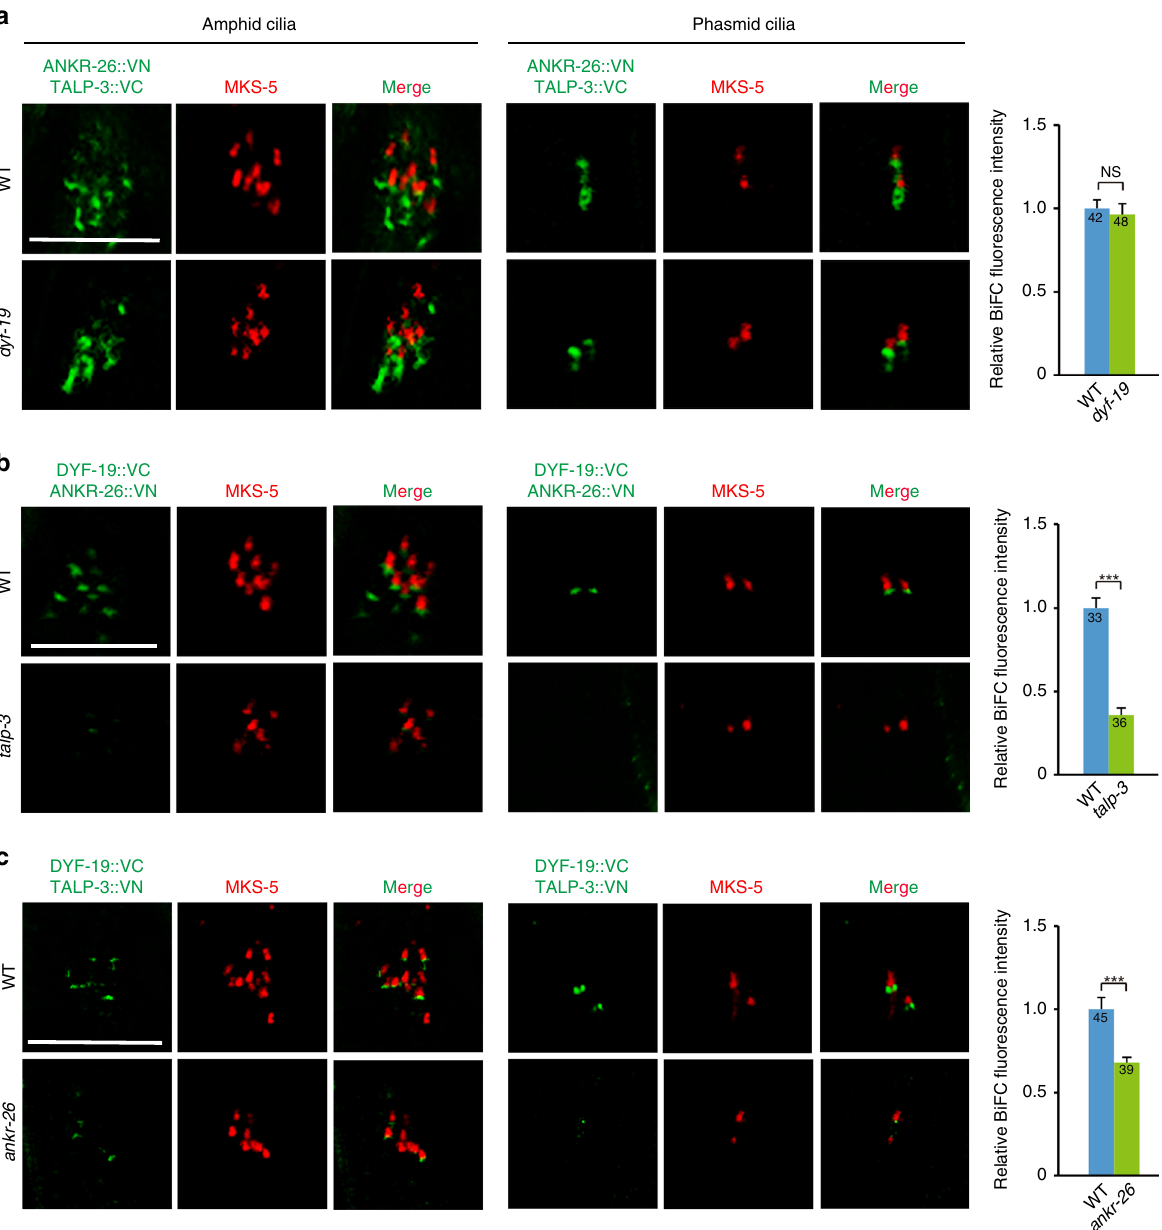
Fig. 4 In vivo interactions among TALP-3, ANKR-26 and DYF-19 in the corresponding mutants. a BiFC signal between ANKR-26::VN and TALP-3::VC in amphid cilia and phasmid cilia and relative fl uorescence intensity in WT and dyf-19 mutant worms. Stable fl uorescence complementation between ANKR- 26::VN and TALP-3::VC is observed in WT worms, and the signal is not impaired in dyf-19 mutants. b BiFC signal between ANKR-26::VN and DYF-19::VC in amphid cilia and phasmid cilia and the relative fl uorescence intensity in WT and talp-3 mutant worms. Stable fl uorescence complementation between ANKR-26::VN and DYF-19::VC is observed in WT worms, and the BiFC fl uorescence intensity is dramatically decreased in the talp-3 mutant, suggesting that TALP-3 is required for the proper spatial association between ANKR-26 and DYF-19. c BiFC signal between TALP-3::VN and DYF-19::VC in amphid and phasmid cilia, and the relative fl uorescence intensity in WT and ankr-26 mutant worms. Stable fl uorescence complementation between TALP-3::VN and DYF-19::VC is observed, and the BiFC fl uorescence intensity is decreased in the ankr-26 mutant, suggesting that ANKR-26 also affects the proper spatial association between TALP-3 and DYF-19 in vivo. All data are presented as the mean ± s.d. Numbers of cilia analyzed are indicated in the bars. NS, P > 0.05; ***, P < 0.001 by two-tailed unpaired Student ’ s t test. Scale bars = 5 μ m. Source data are provided as a Source Data fi